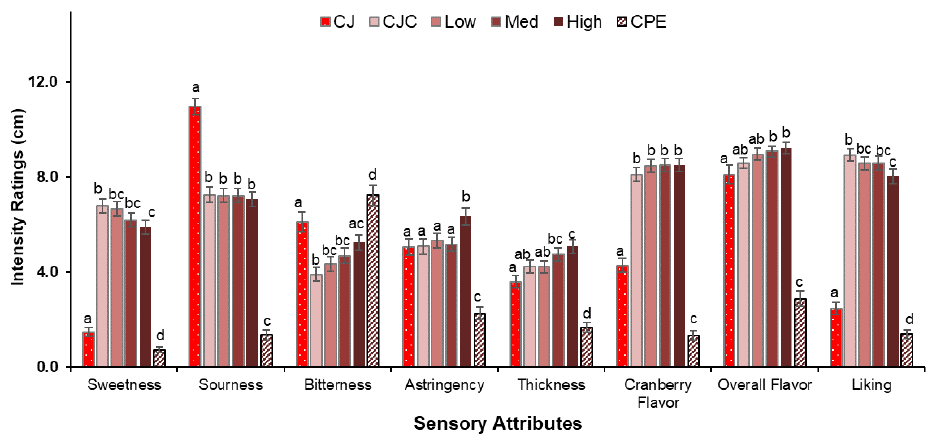
Figure 2. Effect of sample type on attribute intensity ratings (Mean ± SEM) of the CJ, CJC, Low, Med, High and CPE samples. Different superscripts (a, b, etc.) denote statistically significant differences within an attribute based on post-hoc analyses ( p < 0.05).